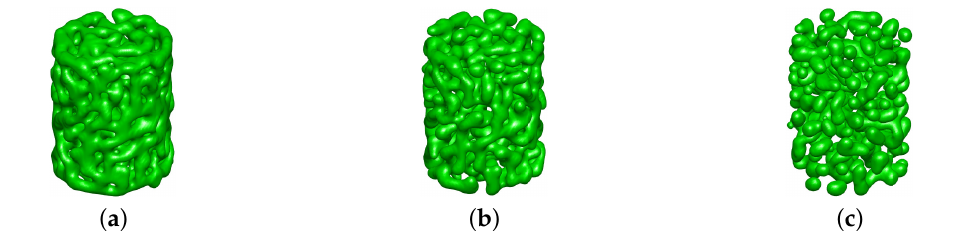
Figure 4. ( a – c ) are zero level isosurfaces of φ at t = 200 ∆ t with f ( x , y , z ) = − 0.15, − 0.3, and − 0.45, respectively, and α = 200.